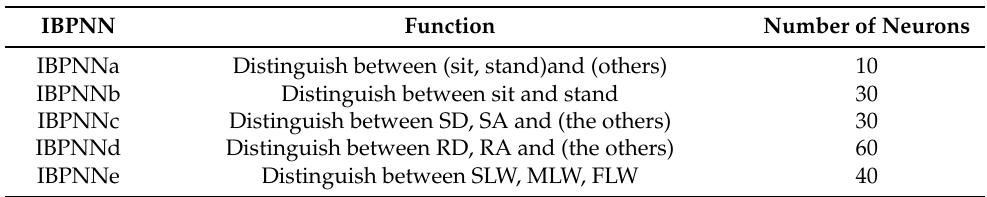
Function and number of neurons for five improved backpropagation neural net- works